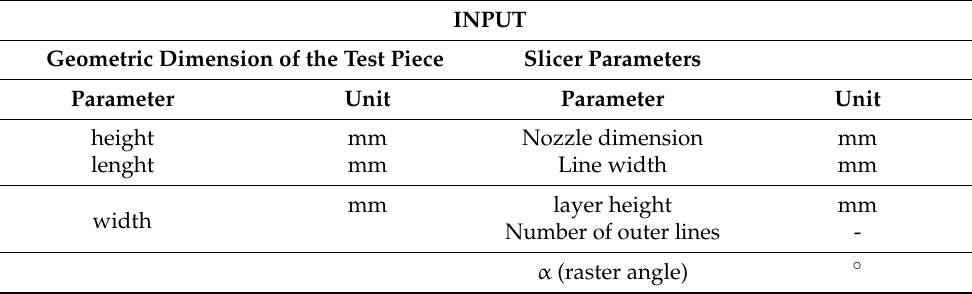
Table 2. Algorithm main output parameters.